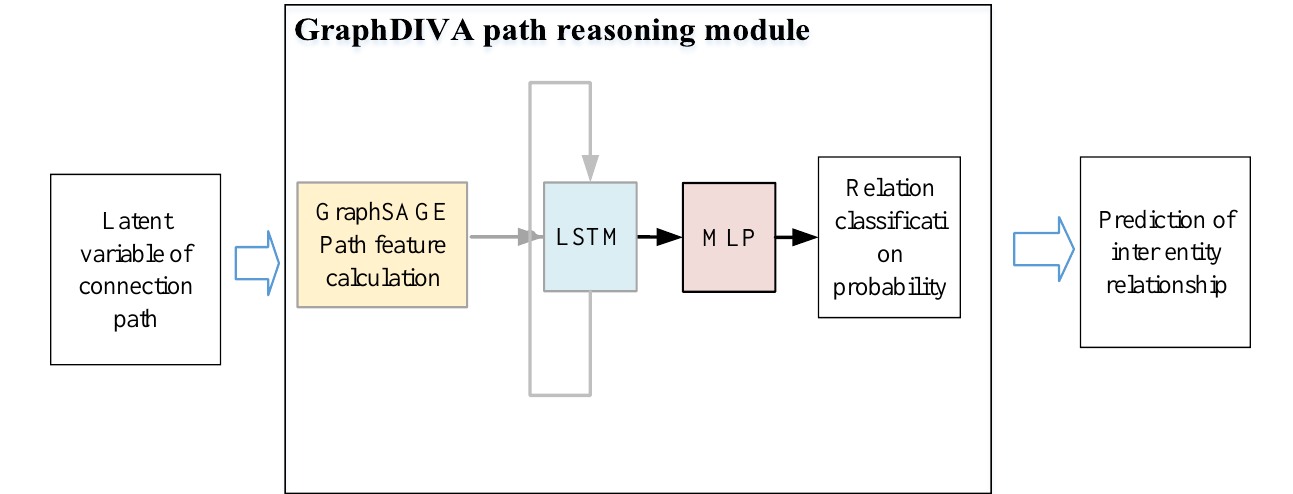
Figure 3. GraphDIVA path reasoning module.